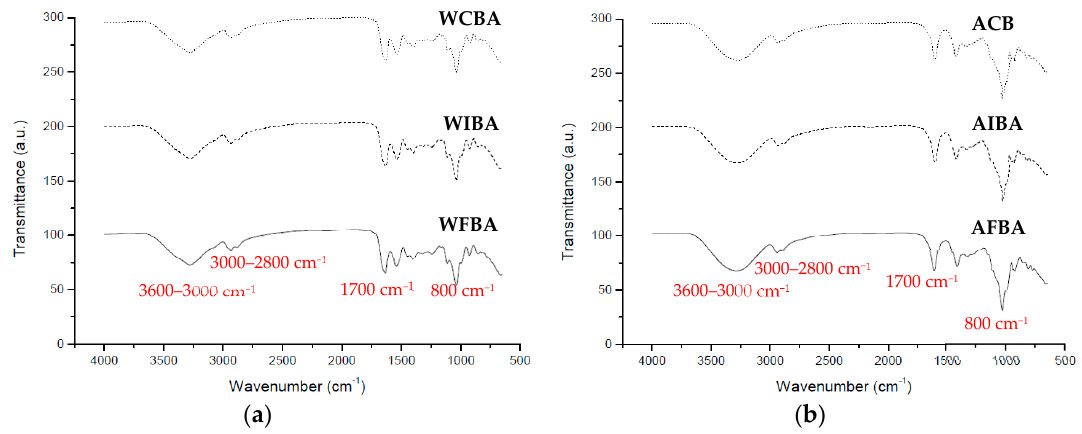
Figure 3. Fourier transform infrared spectroscopy (FTIR) spectra of ( a ) whey protein isolate (WPI)-based and ( b ) alginate (ALG)-based films containing B. animalis subsp. lactis BB-12 with or without prebiotic incorporation at 0 days of storage.